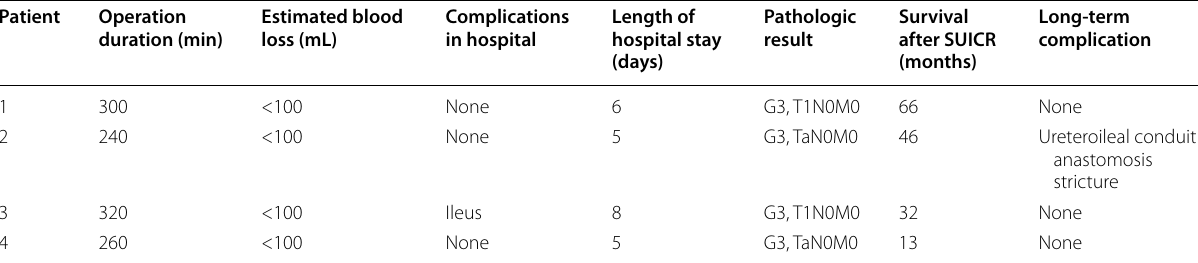
Abbreviation as in Table 1. All patients are recurrence-free at present